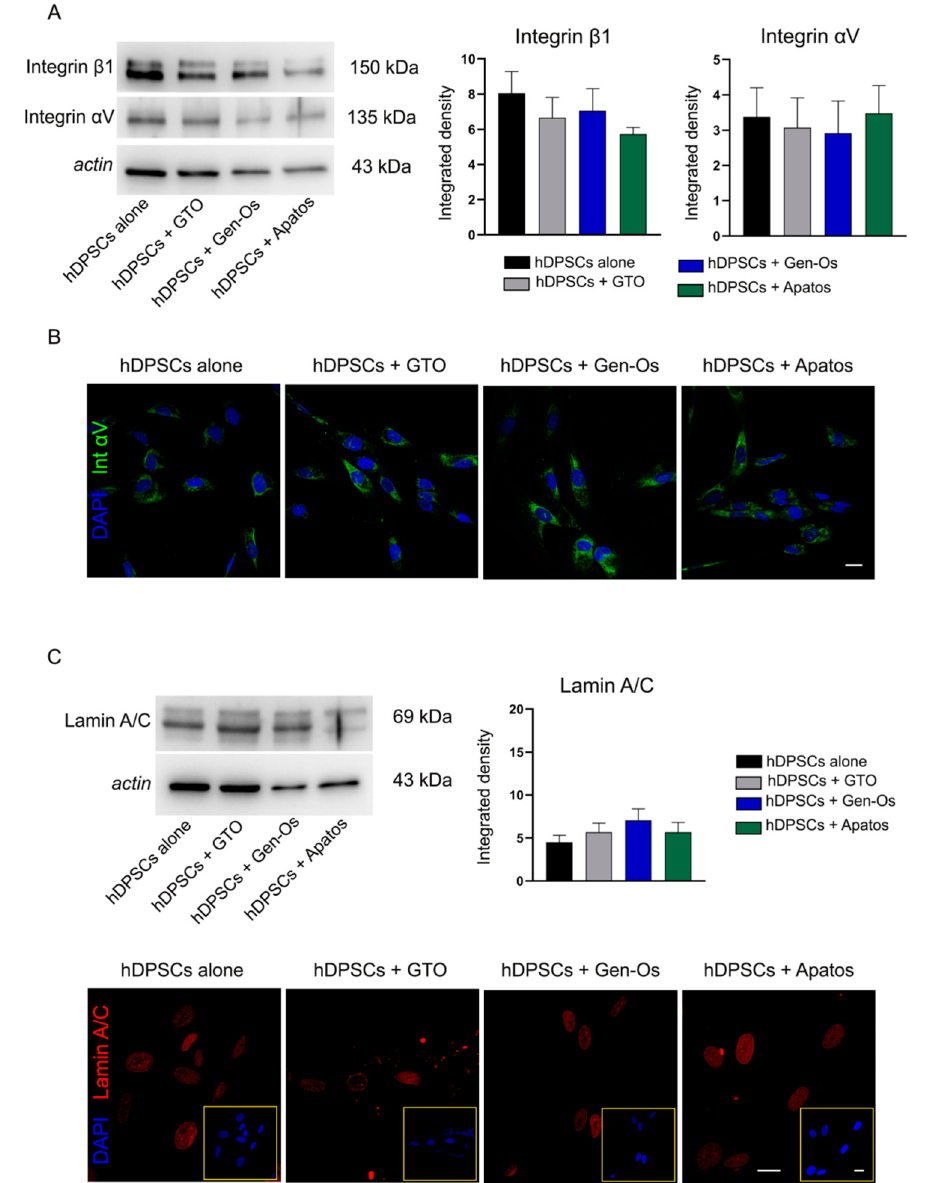
Figure 4. Evaluation of integrin α V/ β 1 and lamin A/C expression. ( A ) The expression of integrin α V and β 1 in hDPSCs following 48 h of BSB treatment is evaluated using Western blot analysis. The densitometric analysis reveals no statistically significant differences in either integrin among the experimental groups. ( B ) Confocal immunofluorescence analysis of integrin α V on hDPSCs treated with BSBs for 48 h. Nuclei are counterstained with DAPI. Scale bar = 10 µ m. ( C ) Western blot analysis of lamin A/C reveals no statistically significant differences among the experimental groups. The perinuclear localization of lamin A/C is confirmed by immunofluorescence analysis. Yellow squares show nuclei stained with DAPI. Scale bar = 10 µ m.